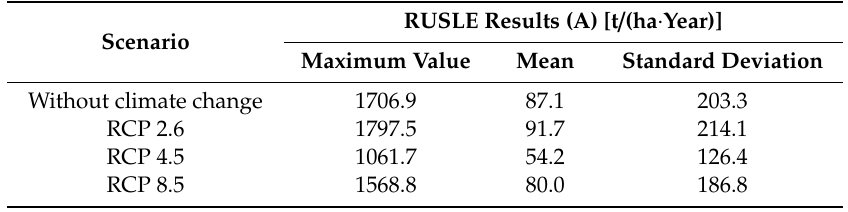
Table 10. Results of the statistical trend of the data in the Guerna catchment, considering di ff erent scenarios and using the RUSLE model.